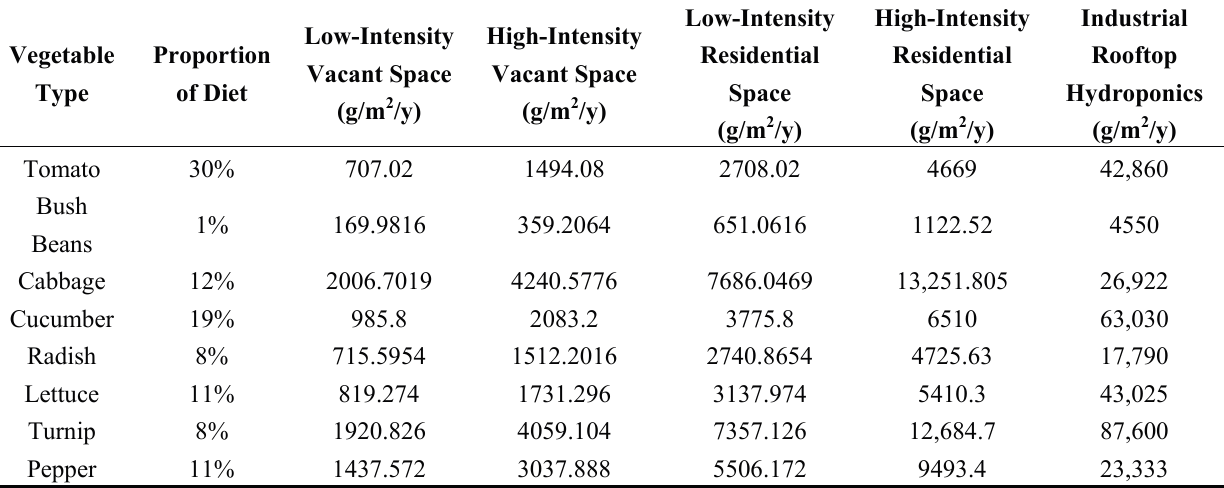
Table 2. Vegetable types and their associated yields using various farm management systems.